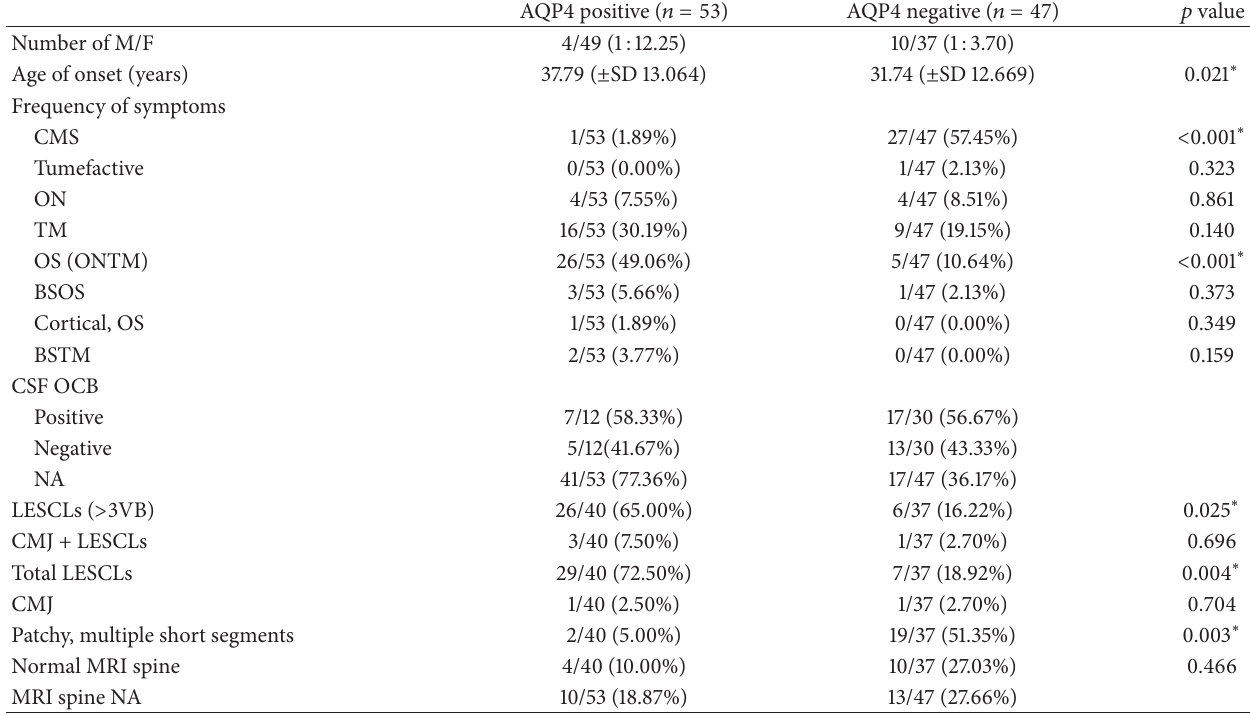
other hand, OS involvement was more common in the